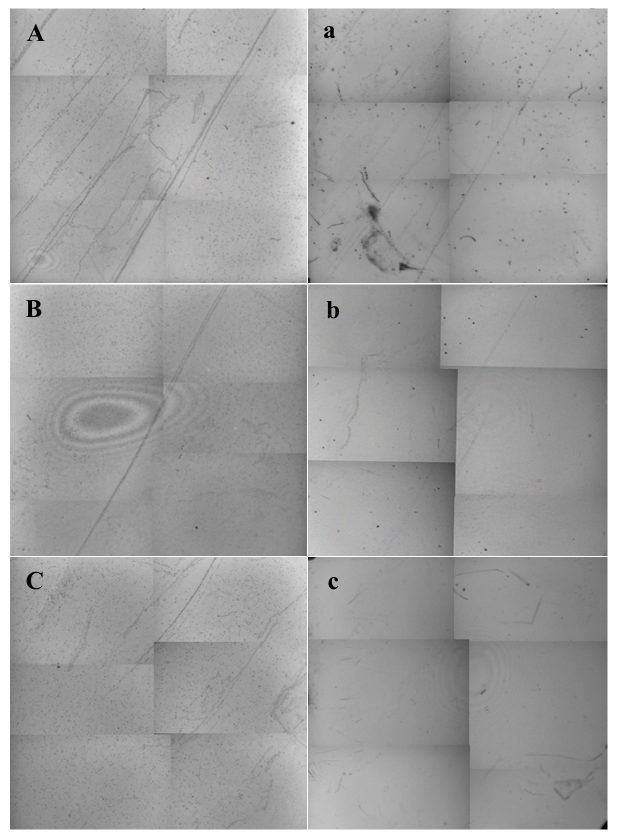
Figure 3. IR images of CMT:In crystals before and after Cd atmosphere annealing: ( A – C ) as-grown; ( a ) 873 K for 240 h; ( b ) 973 K for 240 h; ( c ) 1073 K for 240 h. The size of the images is 9 × 9 mm 2